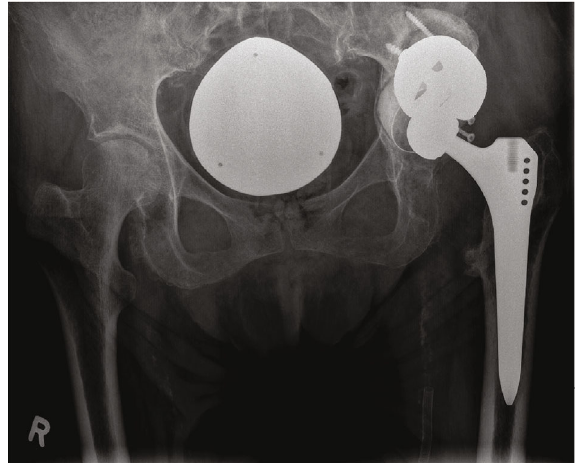
Figure 6: Last X-ray of the patient in clinic after the cemented cup revision. No further episodes of left hip